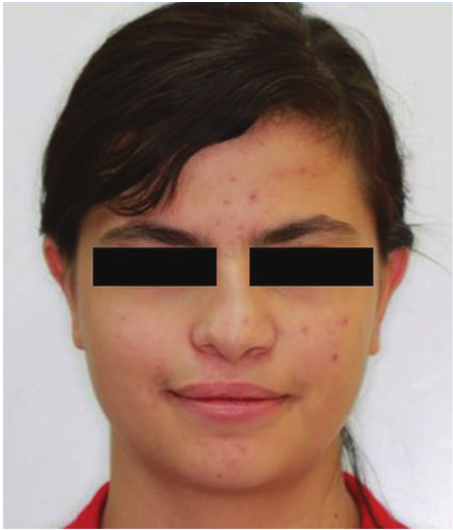
Figure 3: Extraoral front view of patient.